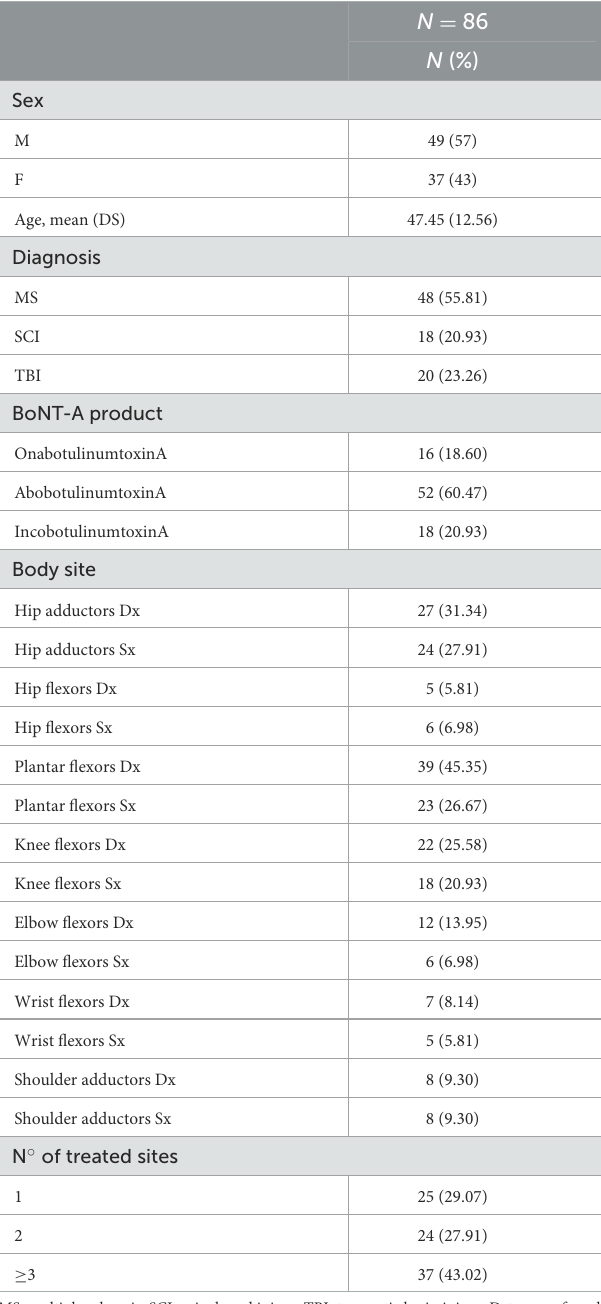
TABLE 1 Demographic characteristics of the study